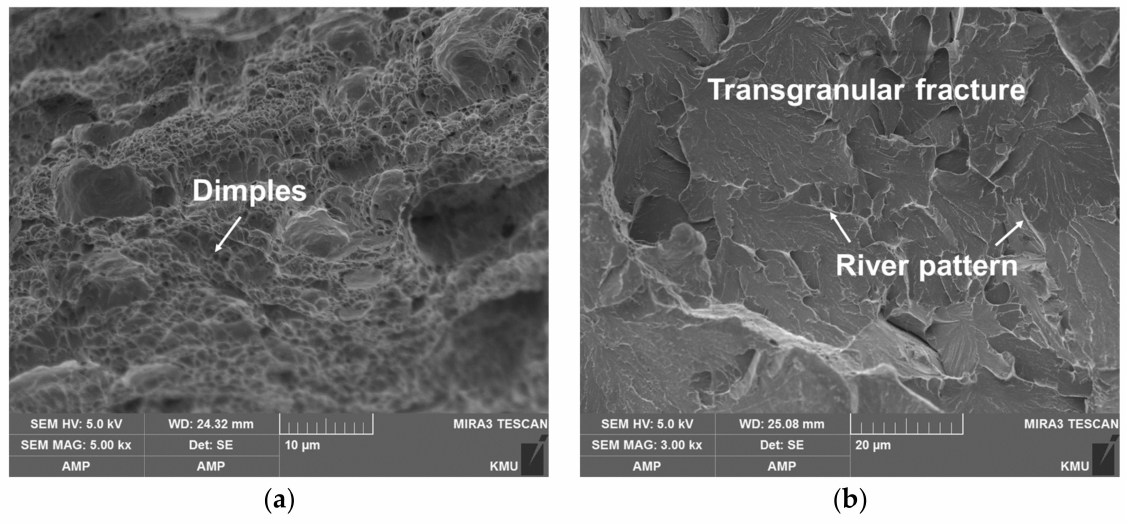
Figure 13. Comparison of average absorbed energies after the Charpy impact